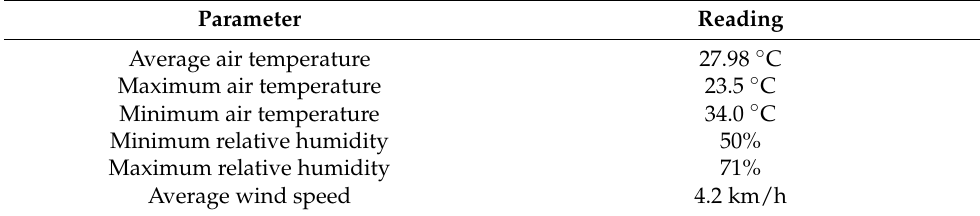
Table 2. Average climate data at the study site for September.